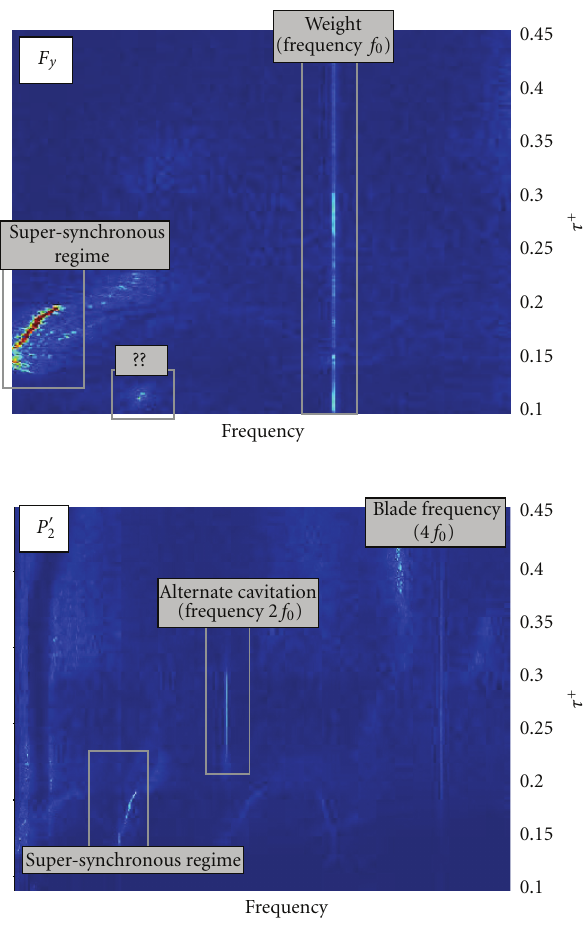
Figure 5: Waterfall plot for F y and P (cid:3) 2 ( Q n , N ref ).